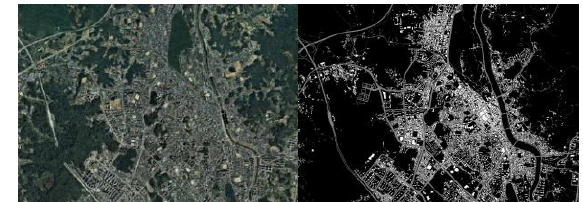
Figure 1. Example of aerial ortho-images and digital maps